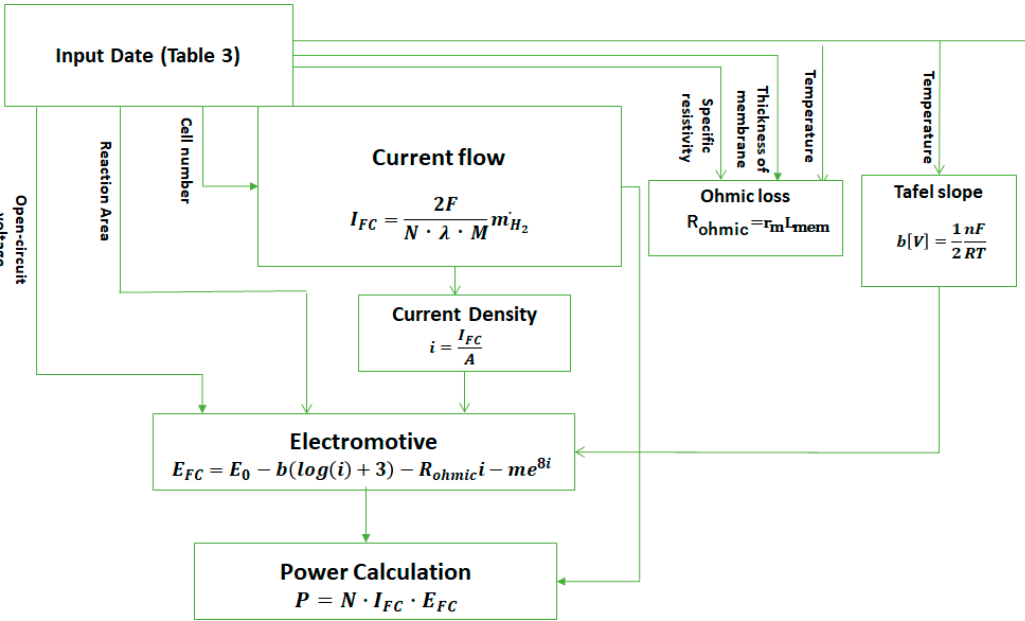
Figure 4. Calculation flow in fuel cell power simulation.